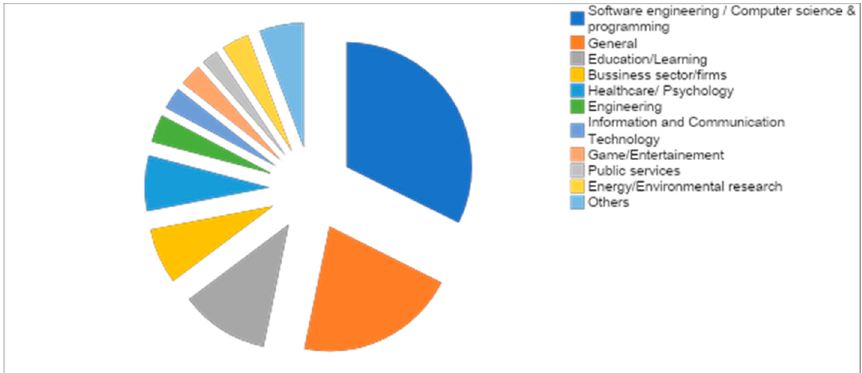
Figure 4. Pie chart of target